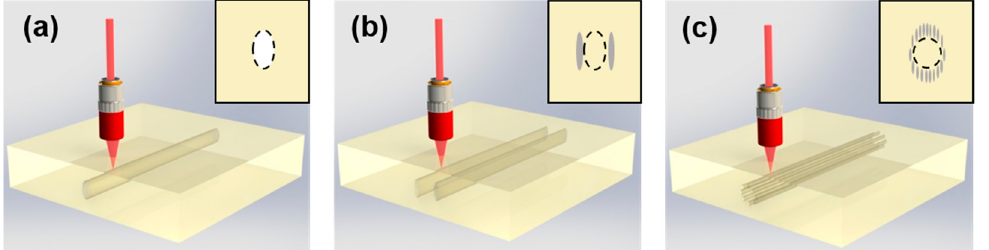
Figure 1. Schematic of the fabrication procedure of femtosecond laser-inscribed waveguides: ( a ) Single-line waveguide, ( b ) Double-line waveguide, and ( c ) Depressed cladding waveguide. The insets indicate the cross-sectional sketches of the waveguides. The shadows represent the fs-laser-induced tracks, and the dashed lines indicate the spatial locations of the waveguide cores.